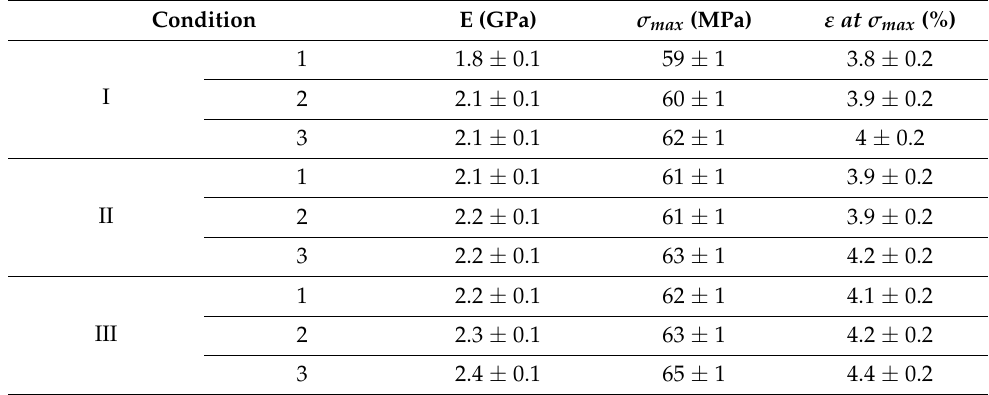
Figure 5. Tensile behavior for the set of samples according to the conditions ( a ) I, ( b ) II, and ( c ) III representing the variation platform temperature and print speed. Table 4. Results of the tensile behavior of printed samples according to conditions I, II, and